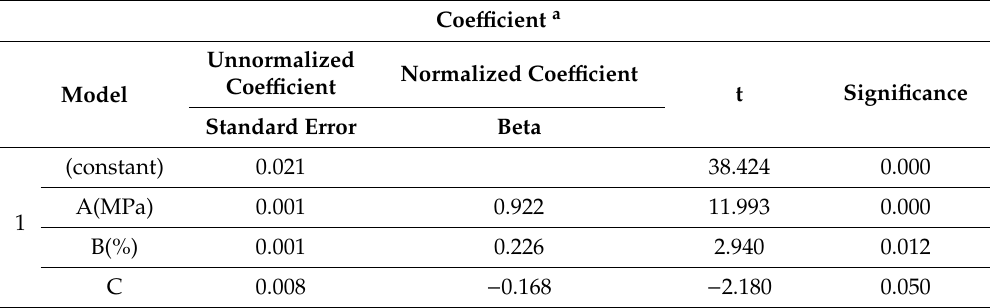
Table 5. Regression coefficient test